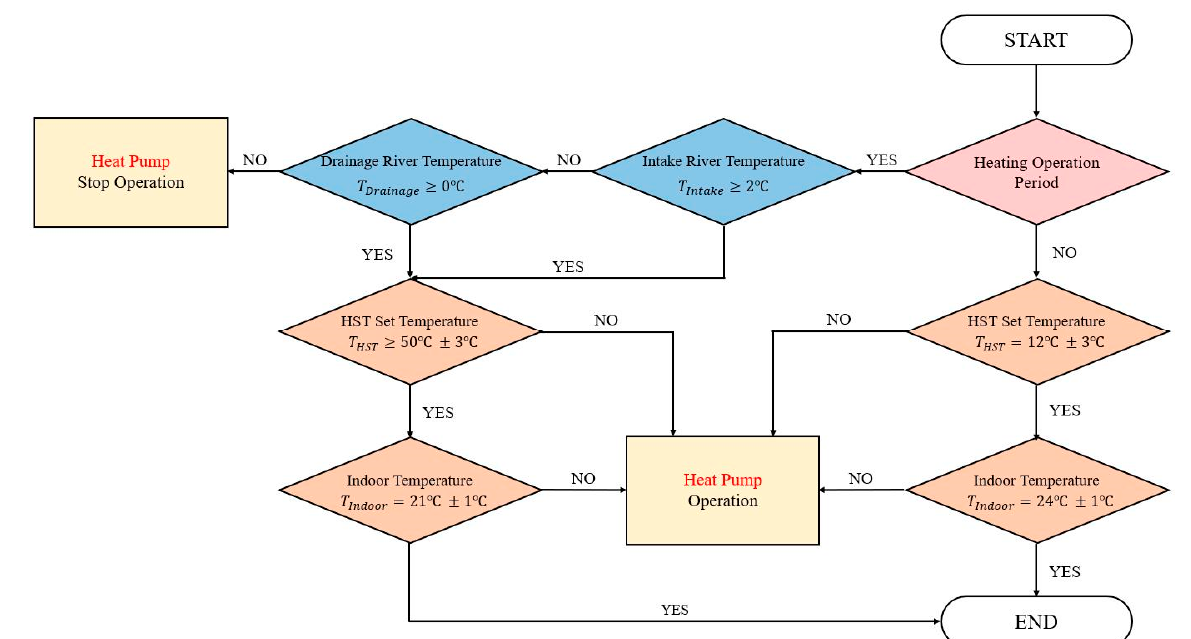
Figure 7. Operational logic of the RWSHP system.